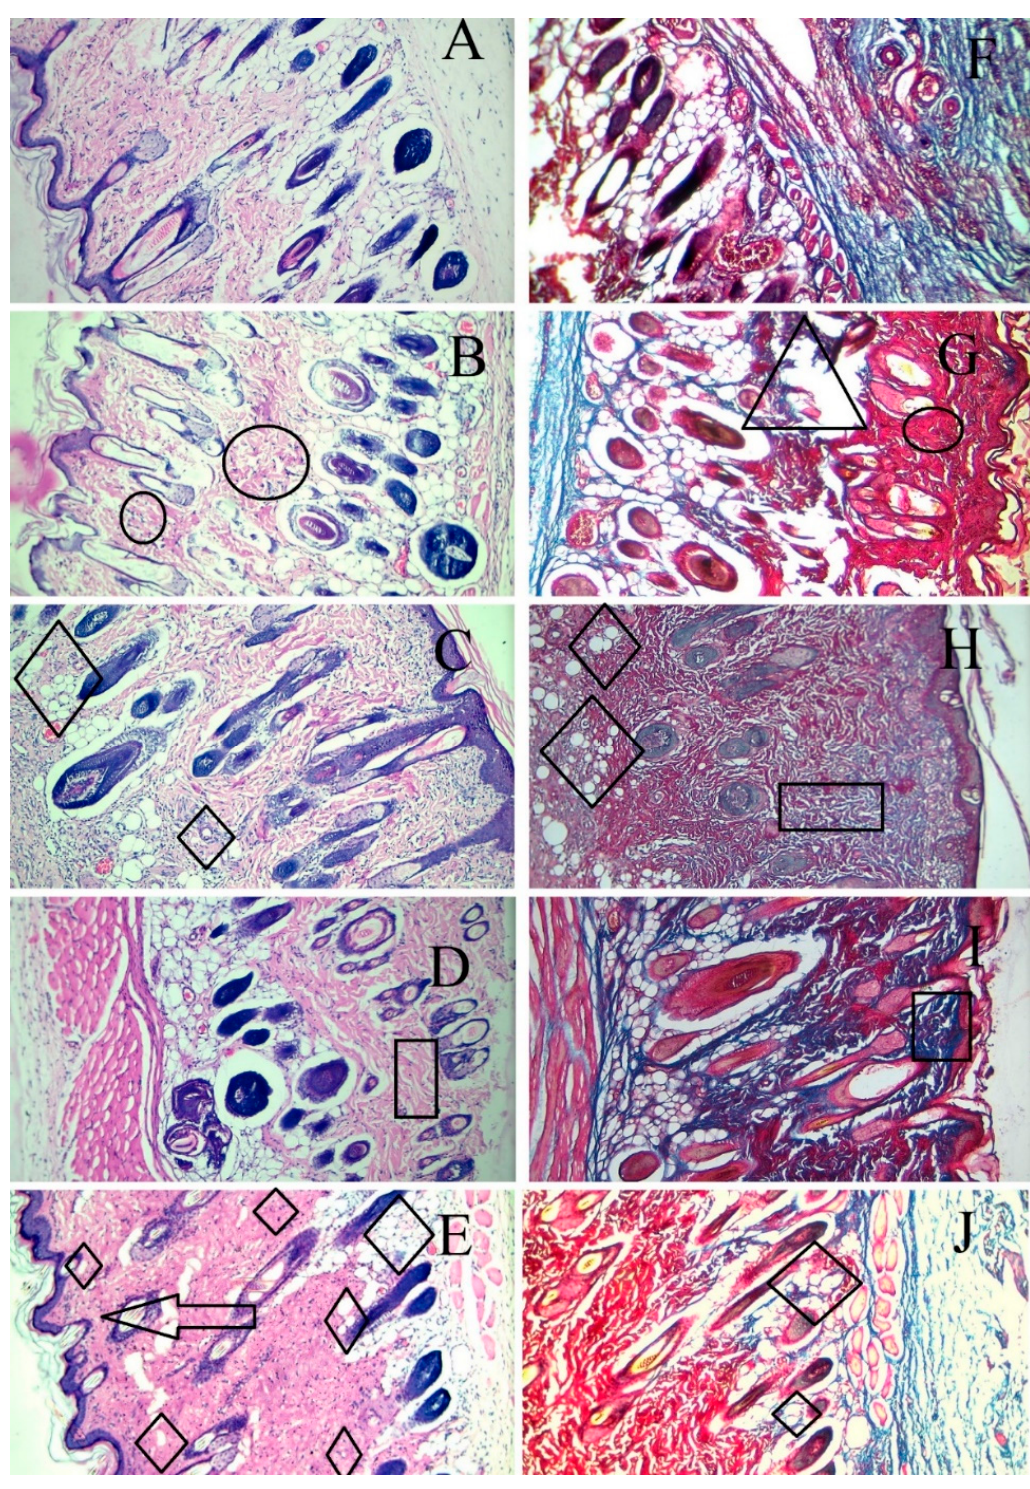
Figure 9. Histological evaluation by H & E and Masson trichome staining of the cutaneous wounds in the rats on the 14th day of treatment. ( A , F ) (healthy rats), ( B , G ) (wounded without intervention), ( C , H ) (F 1 C 1 ), ( D , I ) (1% DFX solution), ( E , F ) (F 1 C 1 .DFX); ( A – E ) for H & E staining, ( F – J ) for Masson trichome staining ( ∆ = Ulceration, O = inflammation, ♦ = angiogenesis, (cid:3) = Proliferation of fibroblasts, —> =